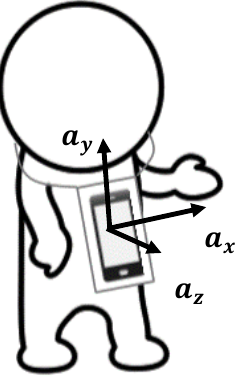
Figure 1. Smartphone sensor worn around the neck. The three axes of the built-in accelerometer are indicated by ( 𝑎 𝑥 ,𝑎 𝑦 ,𝑎 𝑧 ).